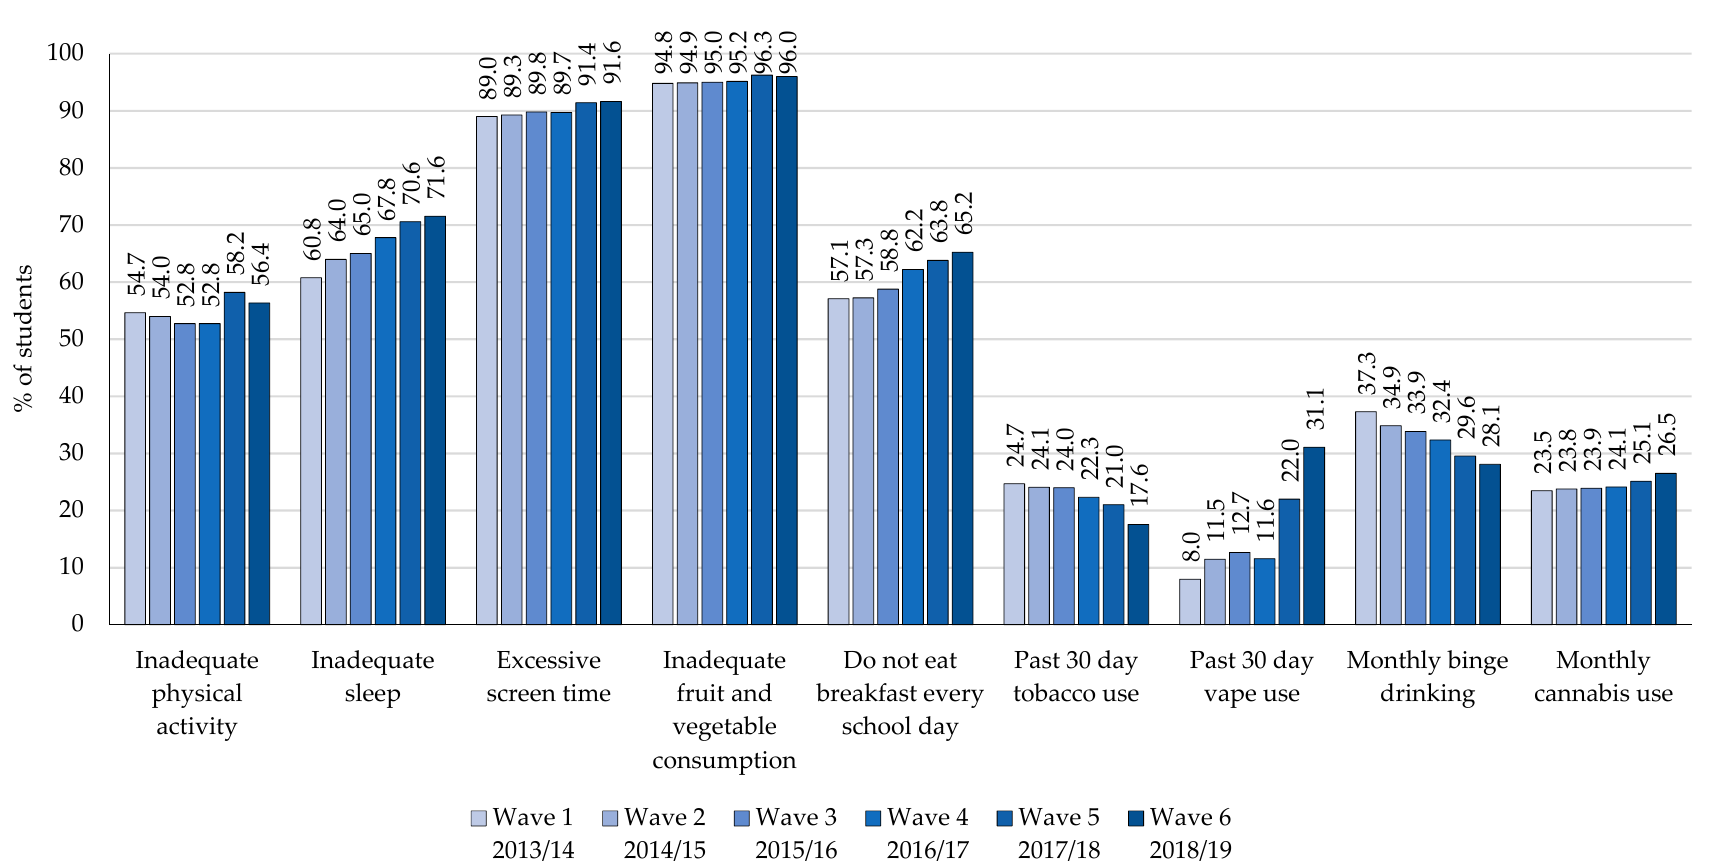
Figure 1. Percentage of grade 12 students (n = 44,740) engaging in health risk behaviours by wave, 2013-19 COMPASS study.